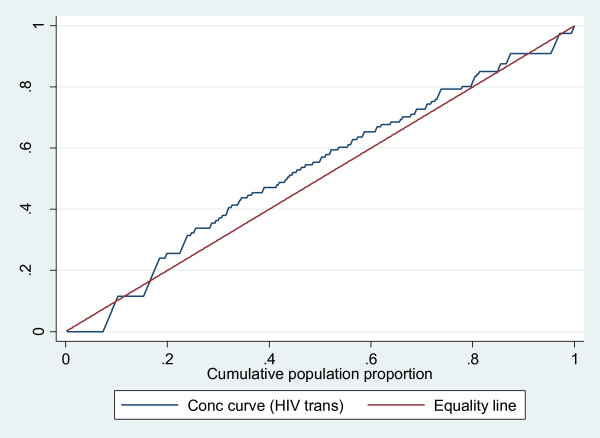
Concentration curve for HIV transmission.